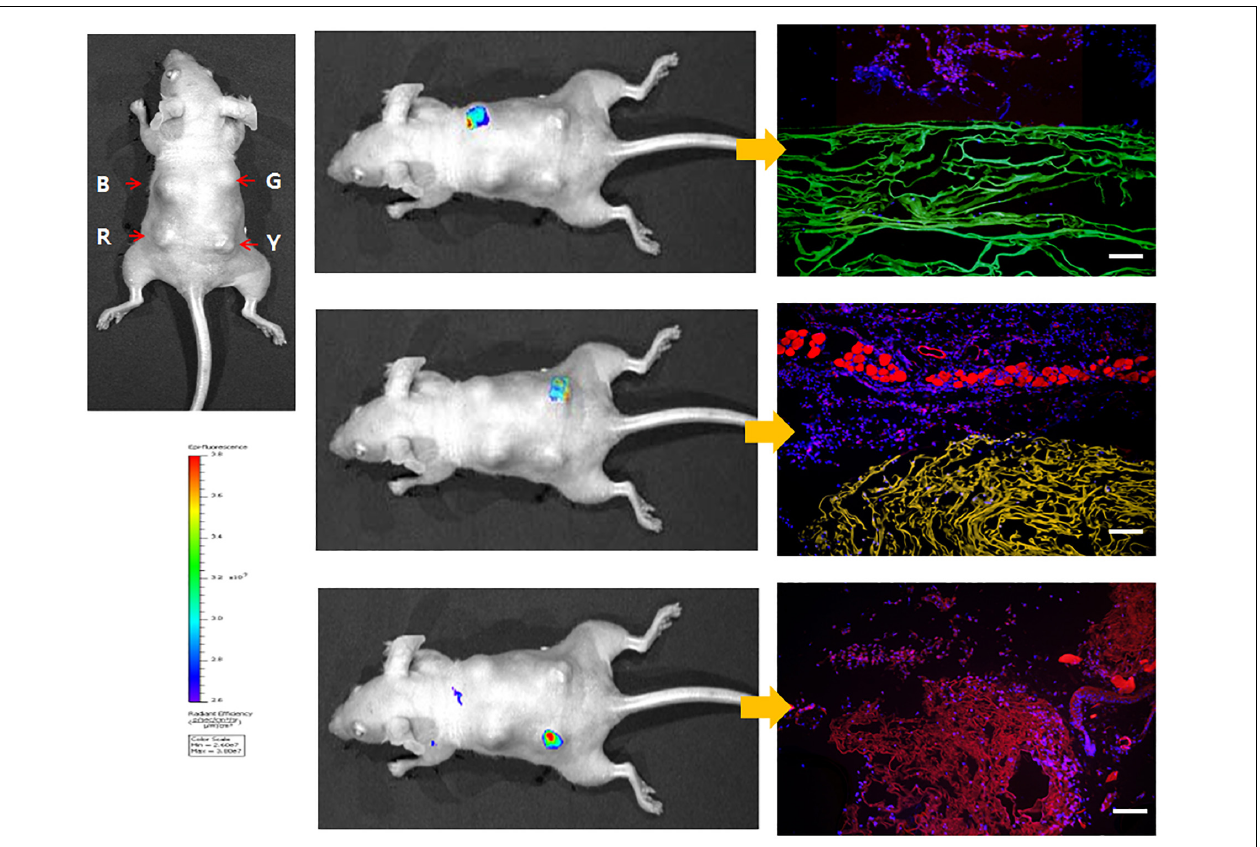
FIGURE 5 | Whole-body imaging of fluorescent SF sponges in the dorsal region of nude mouse at 7 days. The color bar indicates relative signal intensity. (B) B. mori, (G) EGFP, (R) mKate2, (Y) EYFP. Reproduced from Kim et al. (2015) with permission from